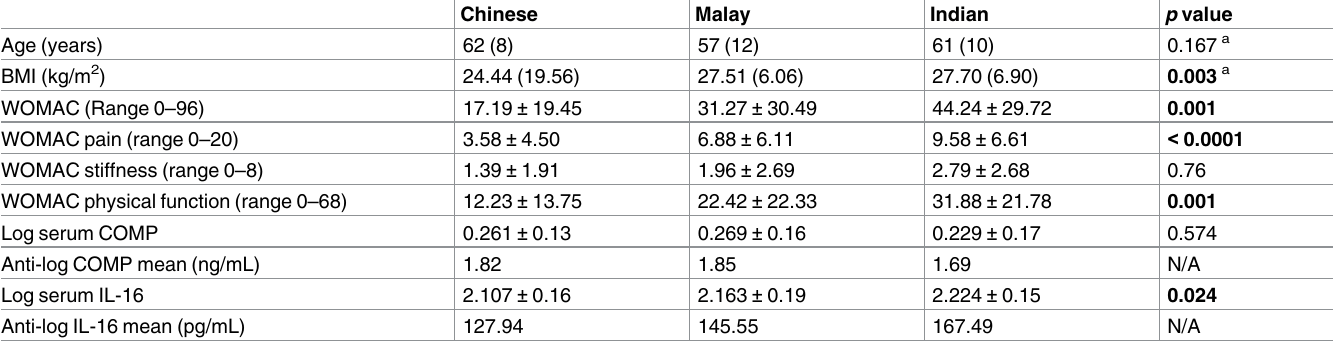
Table 3. Characteristics of the different